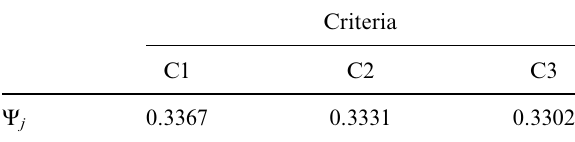
Table 7. FPSI method and fuzzy decision frame work